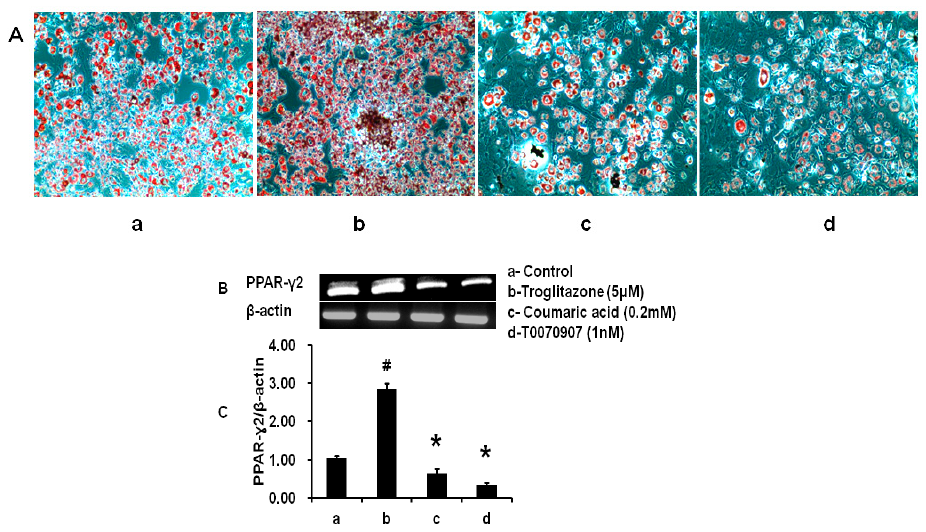
Figure 6. Comparative effects between coumaric acid, troglitazone (TRZ) and T0070907 on lipid accumulation and PPAR- γ 2 mRNA expression. ( A ) lipid droplets stained cells by Oil red O staining method; ( B ) qualitative analysis of PPAR- γ 2 mRNA expression; and ( C ) quantitative analysis of PPAR- γ 2 mRNA expression (a—control; b—troglitazone (5 μ M); c—coumaric acid (0.2 mM); d-T0070907 (1 nM). The results represent the mean ± SEM of six replicates. # p < 0.05 compared to control adipocytes; * p < 0.05 compared to control and TRZ treatment.